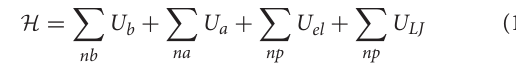
Frontiers in Chemistry |